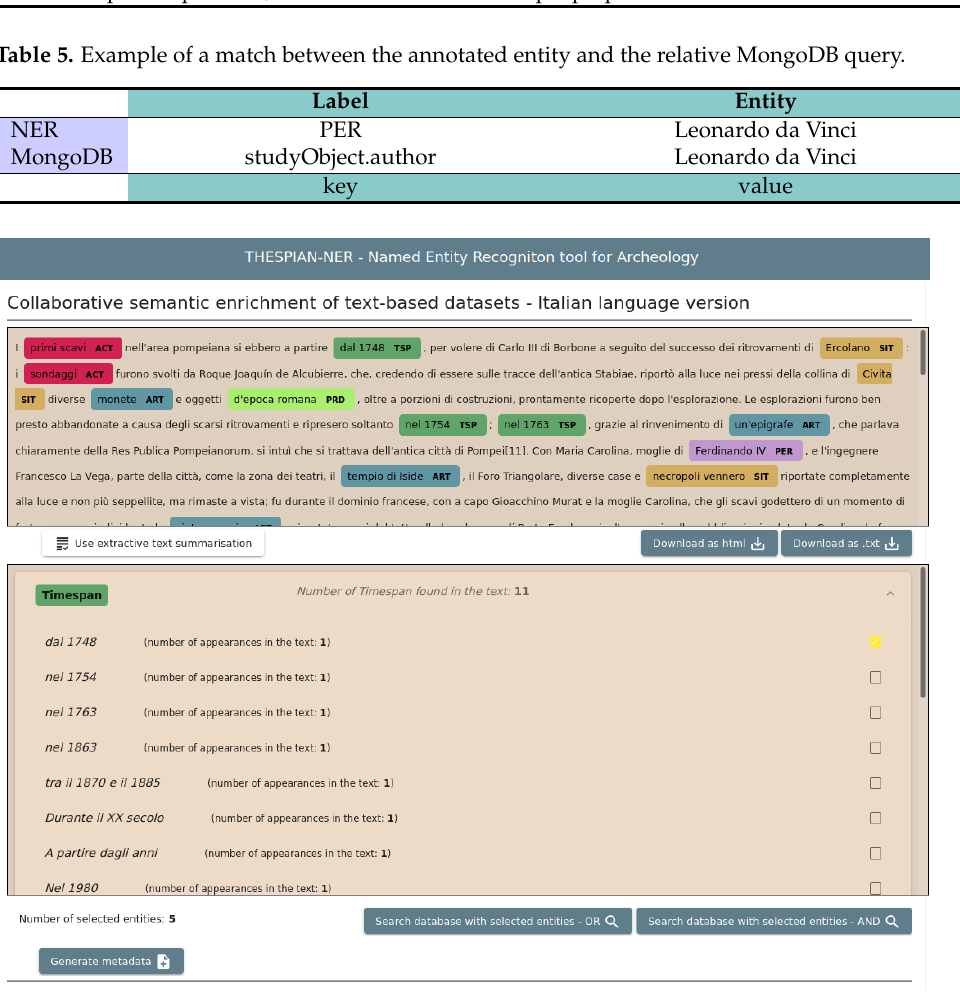
Figure 7. The NER web page after the ArcheoNER analysis. In the opened timespan section, the list of entities are shown. The button for the entity selection can be seen on the right of the entity’s name. At the bottom right, is possible to see the two buttons for querying the database, whereas on the opposite side it is possible to see the number of the chosen entities and the button to generate the prefilled metadata mask and open it in the THESPIAN-Mask web